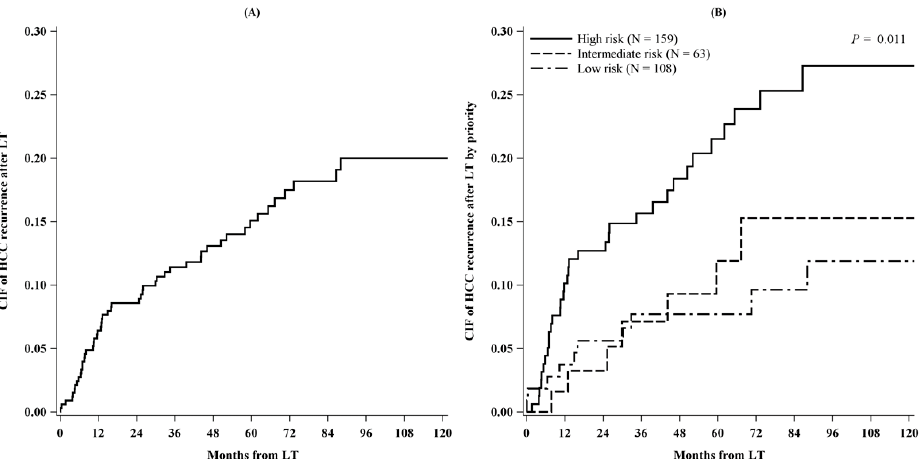
Figure 2. Cumulative incidence of HCC recurrence after liver transplantation overall ( A ) and by priority ( B ) ( N =